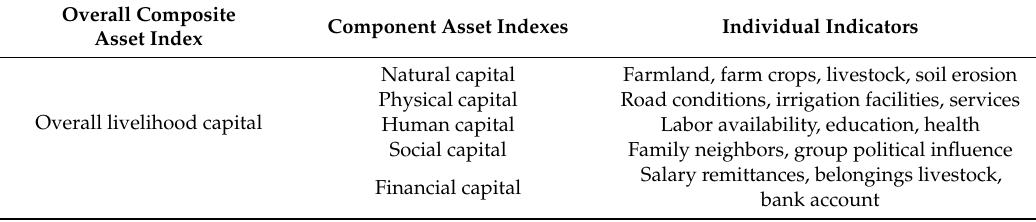
Table 2. Proxy variables of livelihood resilience in the household livelihood resilience approach [81].